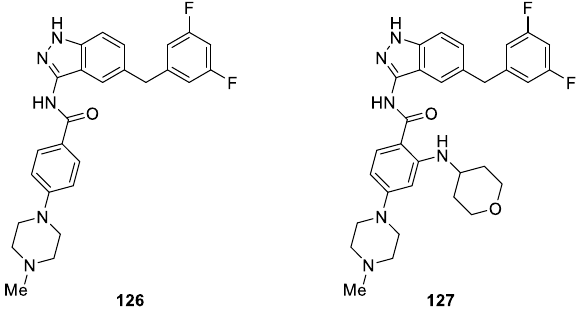
Figure 30. Chemical structures of 3-aminoindazole derivatives 126 and 127 as ALK inhibitors.